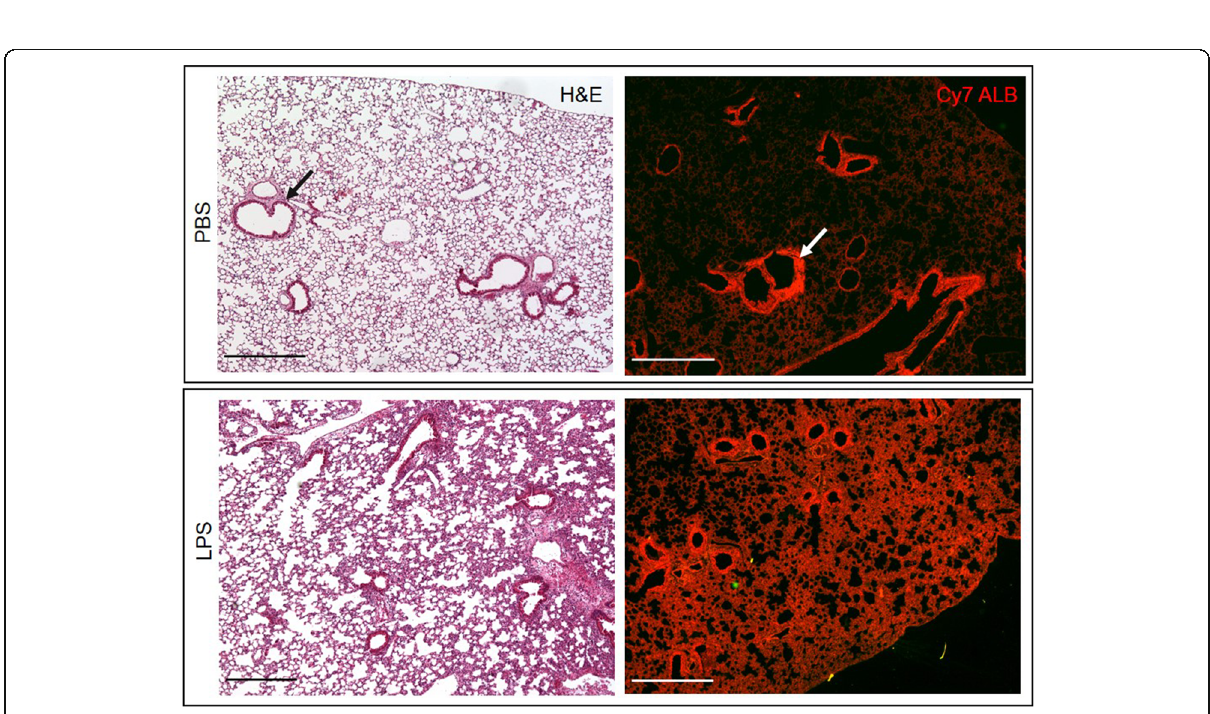
Fig. 2 Cy7-albumin uptake in lung parenchyma of mice 72 h after PBS or LPS treatment visualized under a fluorescent microscope. Bronchovascular bundles (arrows) are visualized on H&E stained sections. Note considerable accumulation of Cy7-albumin (red) in parenchyma of LPS-damaged lungs 24 h post injection. Scale bars, 250 μ